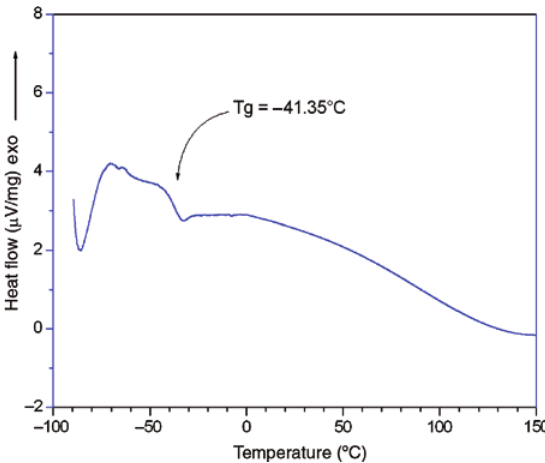
Figure 5: Differential scanning calorimetry (DSC) thermogram of polyphenylmethylsiloxane (PPMS) obtained after 150 min.